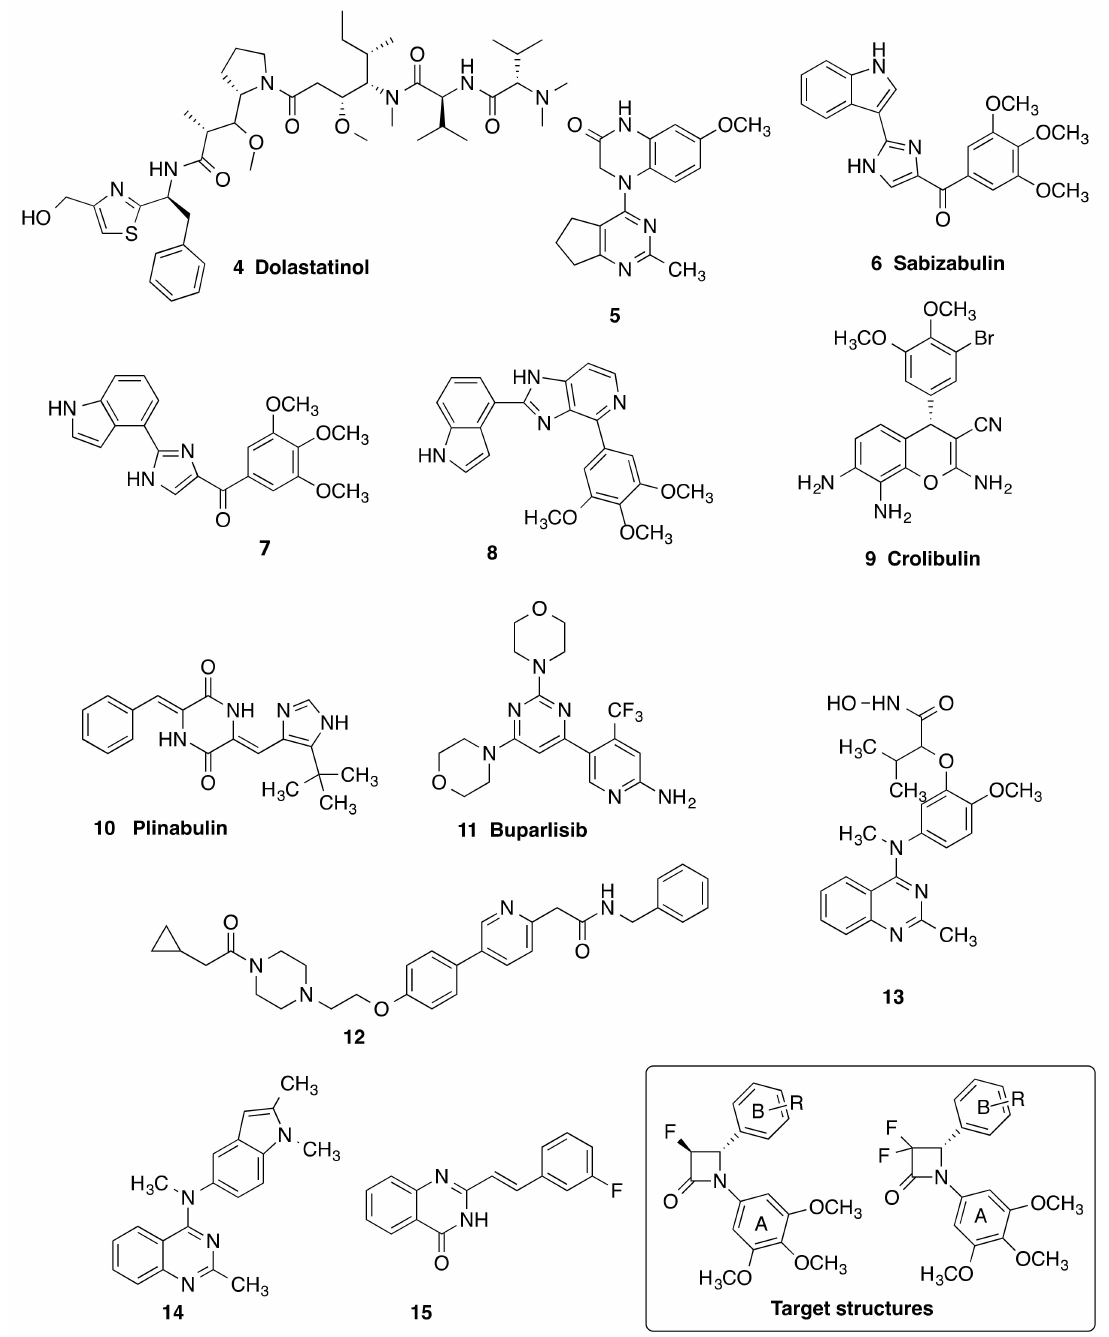
Figure 2. Microtubule-targeting agents 4 – 15 and target